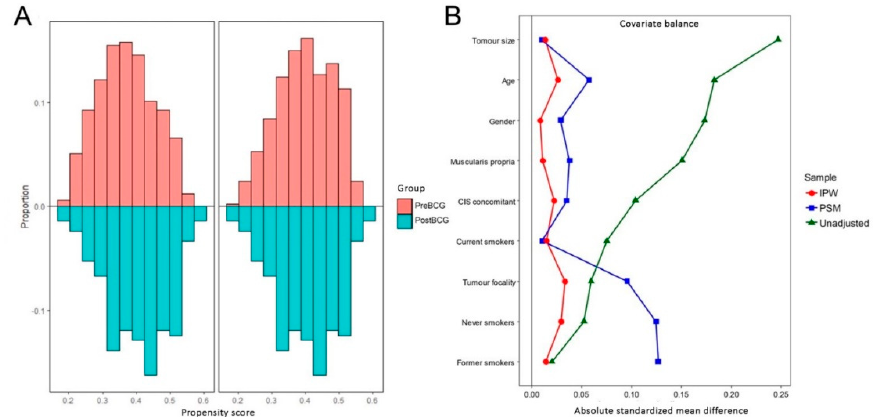
Figure 3. ( A ) Histogram distribution of propensity scores before and after PSM between the study groups . ( B ) Covariate balance before adjustment and after PSM and IPW (inverse probability of treatment weighting). IPW, inverse-probability weighting; PSM, propensity-score-matching.